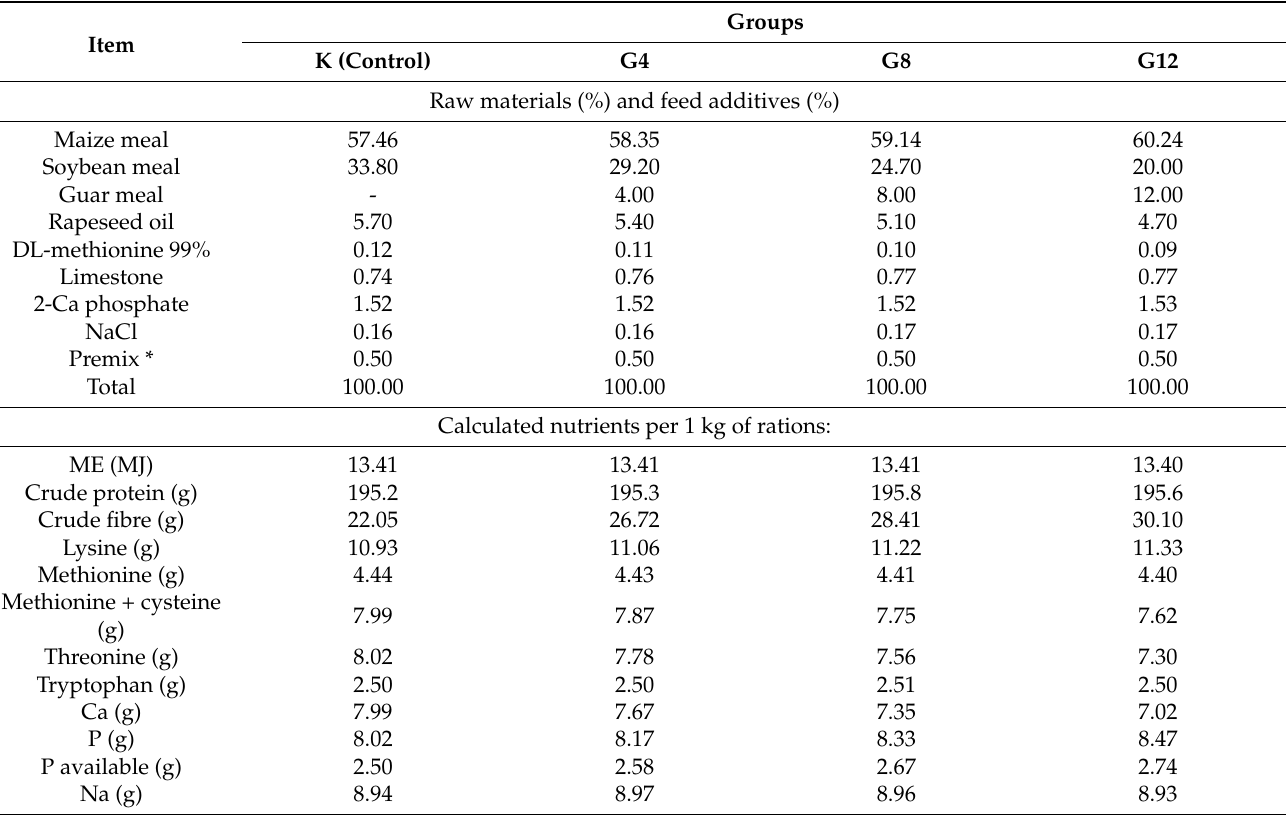
Table 3. Composition and nutritive value of finisher rations containing graded levels of guar